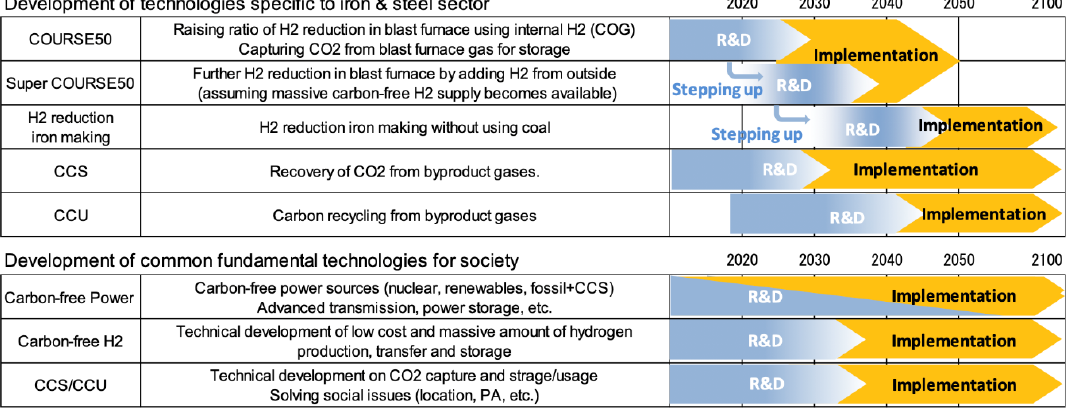
Figure 28. Long-term vision of the Japanese iron and steel industry for zero-carbon steelmaking [66].